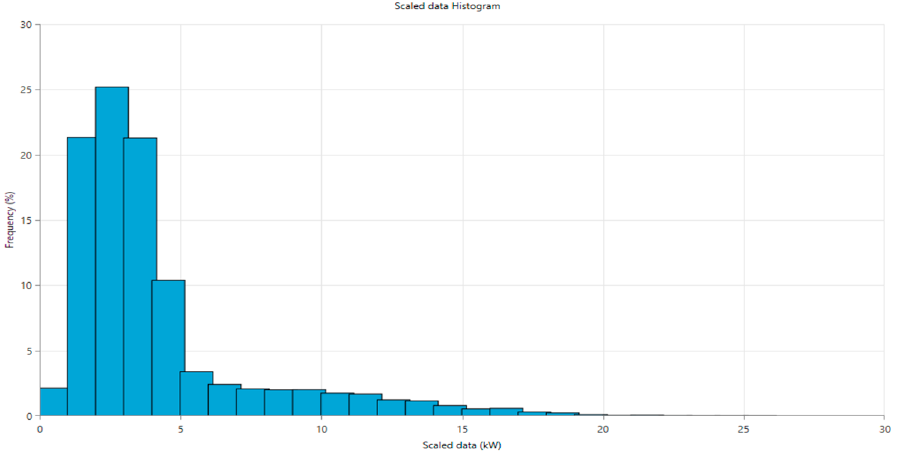
Figure 6. Frequency of the scaled load profile.